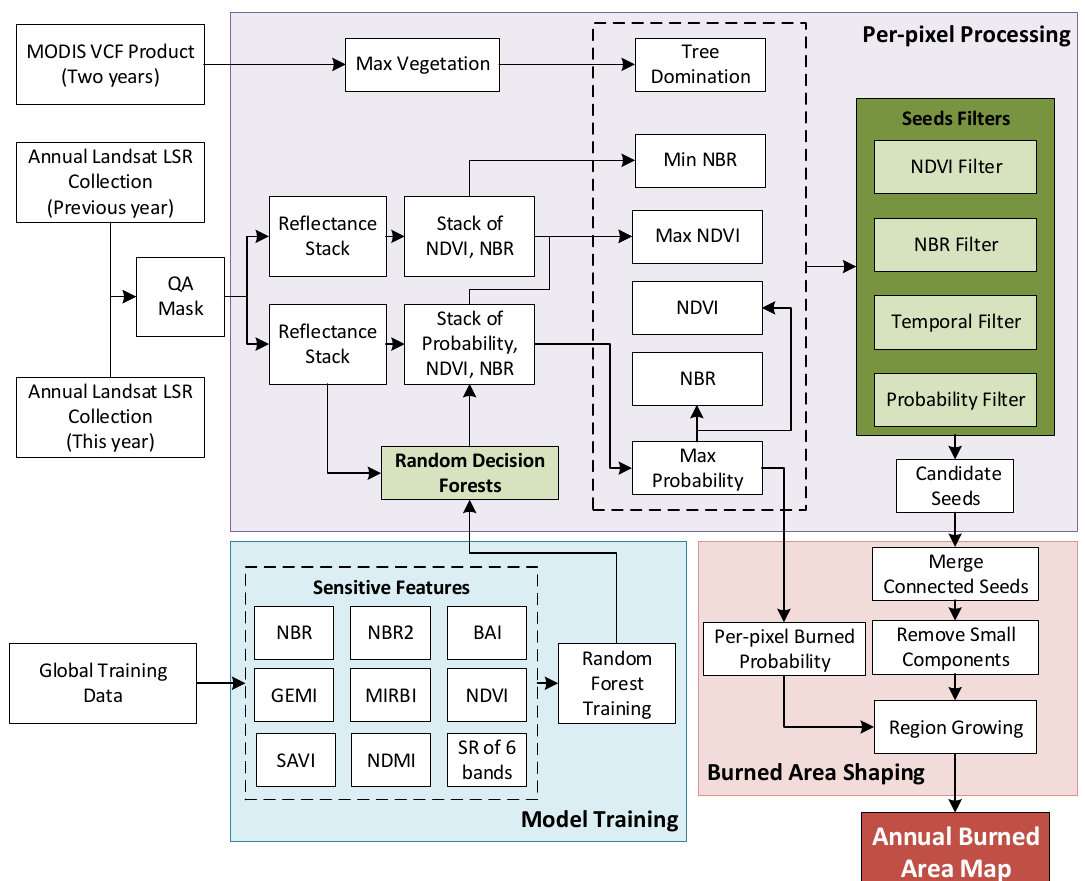
Figure 3. Workflow for annual burned area mapping using Google Earth Engine. LSR, Land Surface